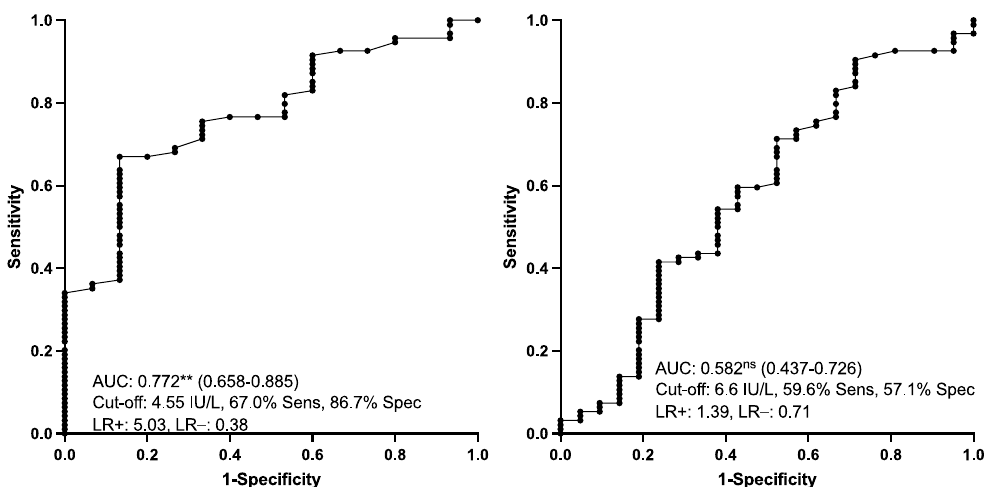
Figure 4. Salivary aldolase activity observed in healthy horses (Control), horses diagnosed with eq- uine gastric ulcer syndrome (EGUS), and horses with similar symptomatology of EGUS but diag- nosed with other gastrointestinal disorders (Other). The median values are represented by the lines, the 10–90 percentiles by the boxes, and the range by the whiskers. *: p < 0.05; **: p < 0.01.